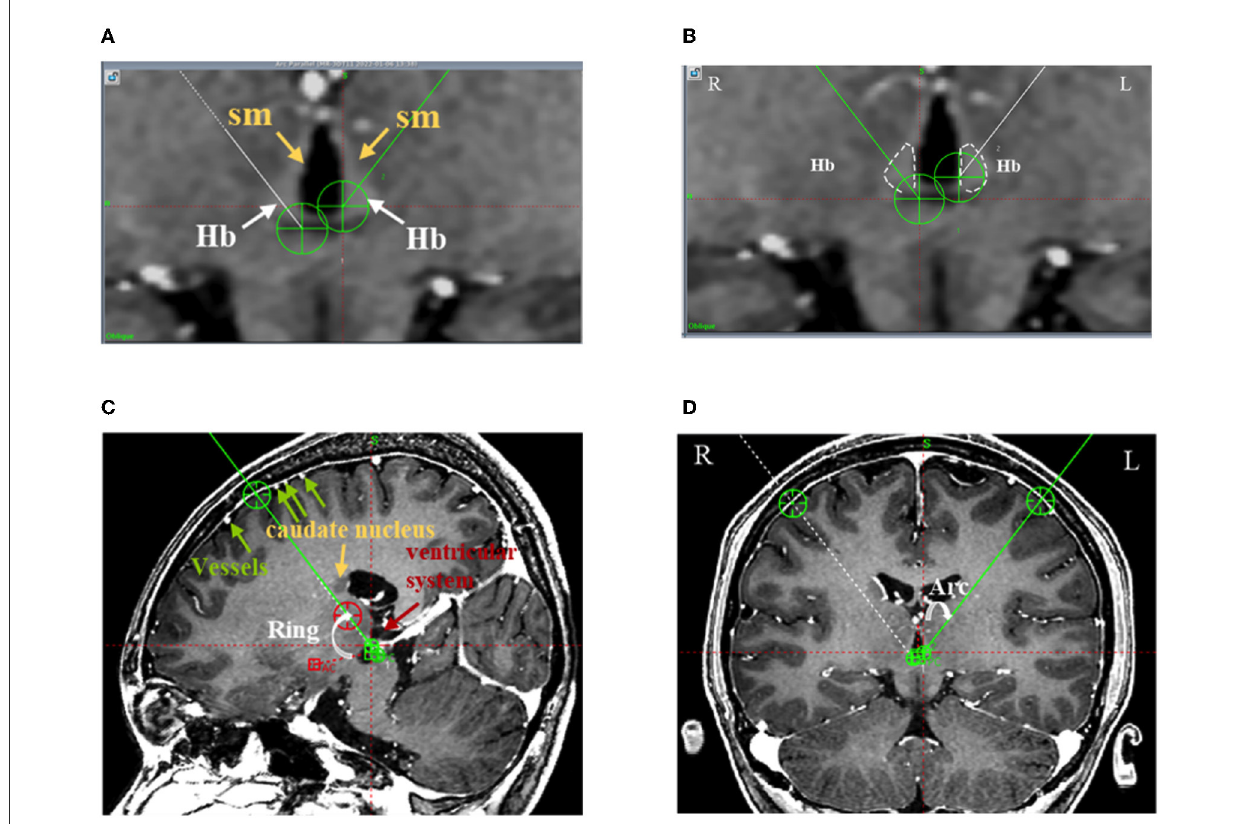
FIGURE2 The frontal trajectory to the left LHb was planned using 3D T1 angiography images in Case 4. (A) The Hb and its afferent fiber tract (stria medullaris, sm) clearly distinguished from the surrounding gray matter and cerebrospinal fluid in the T1-weighted image; (B) The bilateral Hb delineated in white and the DBS electrode targeting the center of the left Hb; (C) The entry point of the planned frontal trajectory on the coronal plane, avoiding the cortical vessels, caudate nucleus, and ventricular system. Additionally, the planned frontal trajectory to the left side was at an angle of 59.10 ◦ relative to the AC-PC level on the sagittal plane (Ring); (D) The planned frontal trajectory to the left side was at an angle of 37.70 ◦ relative to the midline of the sagittal plane